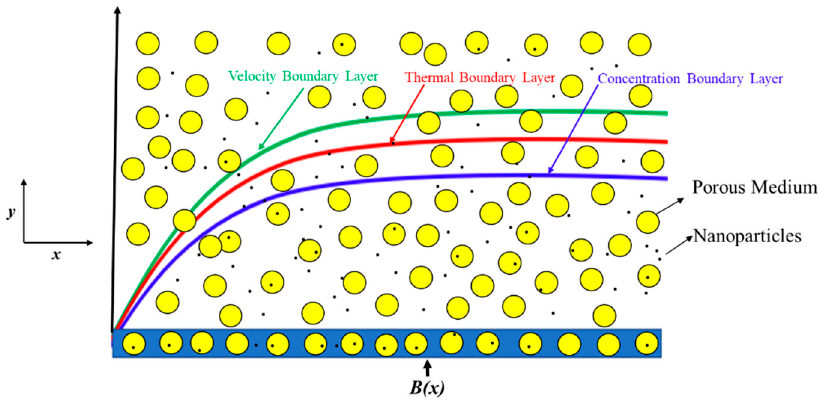
Figure 1. Physical model of the